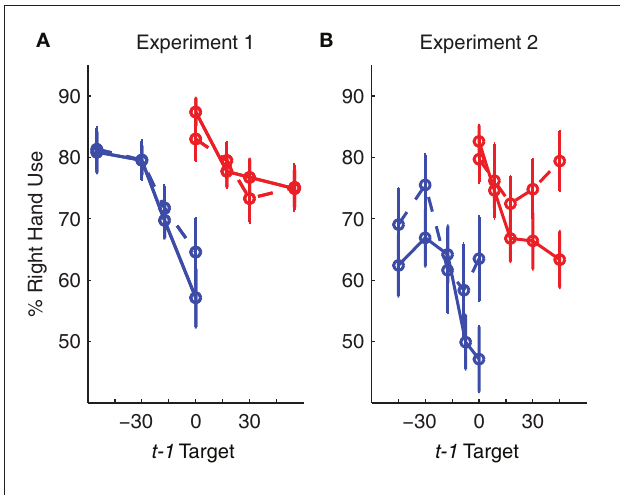
Figure 4 | Sequential analysis of hand choice for experiment 1 (A) and experiment 2 (B). The functions depict the probability of right hand use for targets at the center location (0 ° ) as a function of the previous trial ( n − 1), divided by the location of the last target, the hand used on the last trial, and the outcome on that trial. Right miss (red dashed), right hit (red solid), left miss (blue dashed), left hit (blue solid).